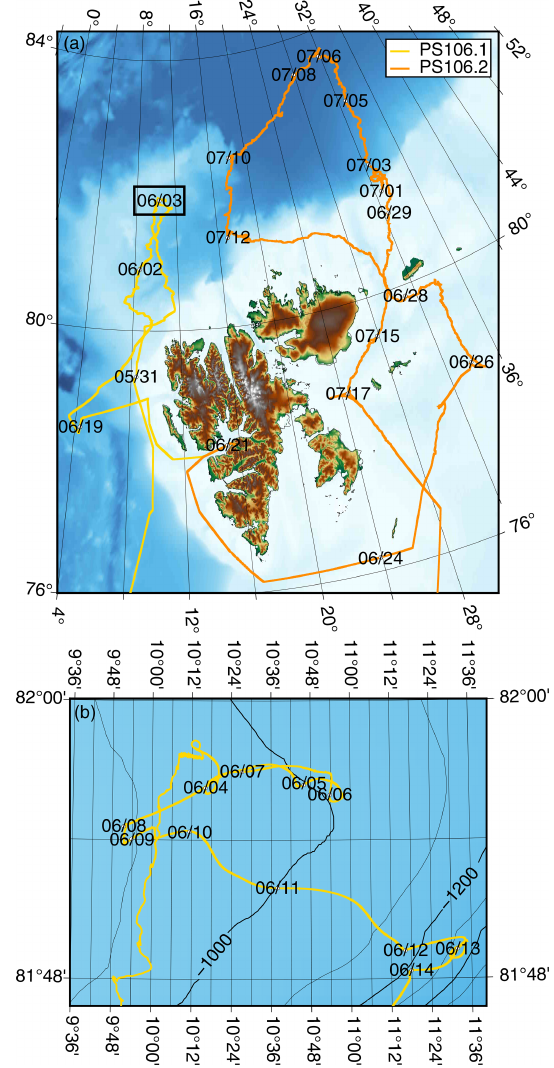
Figure 1. Track of RV Polarstern during (a) PS106. PASCAL (PS106.1; yellow) was the first part of PS106 and was accompanied by (b) a 2-week drift during which the ice floe camp was performed. Map created with GMT (Wessel et al.,